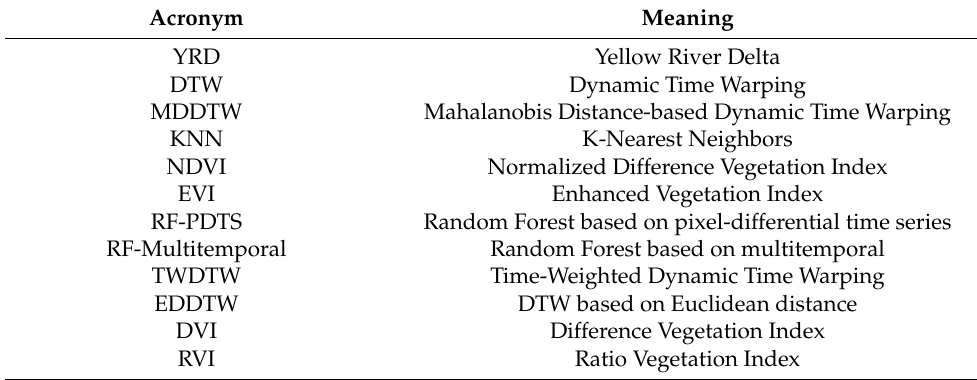
Table A1. Acronym